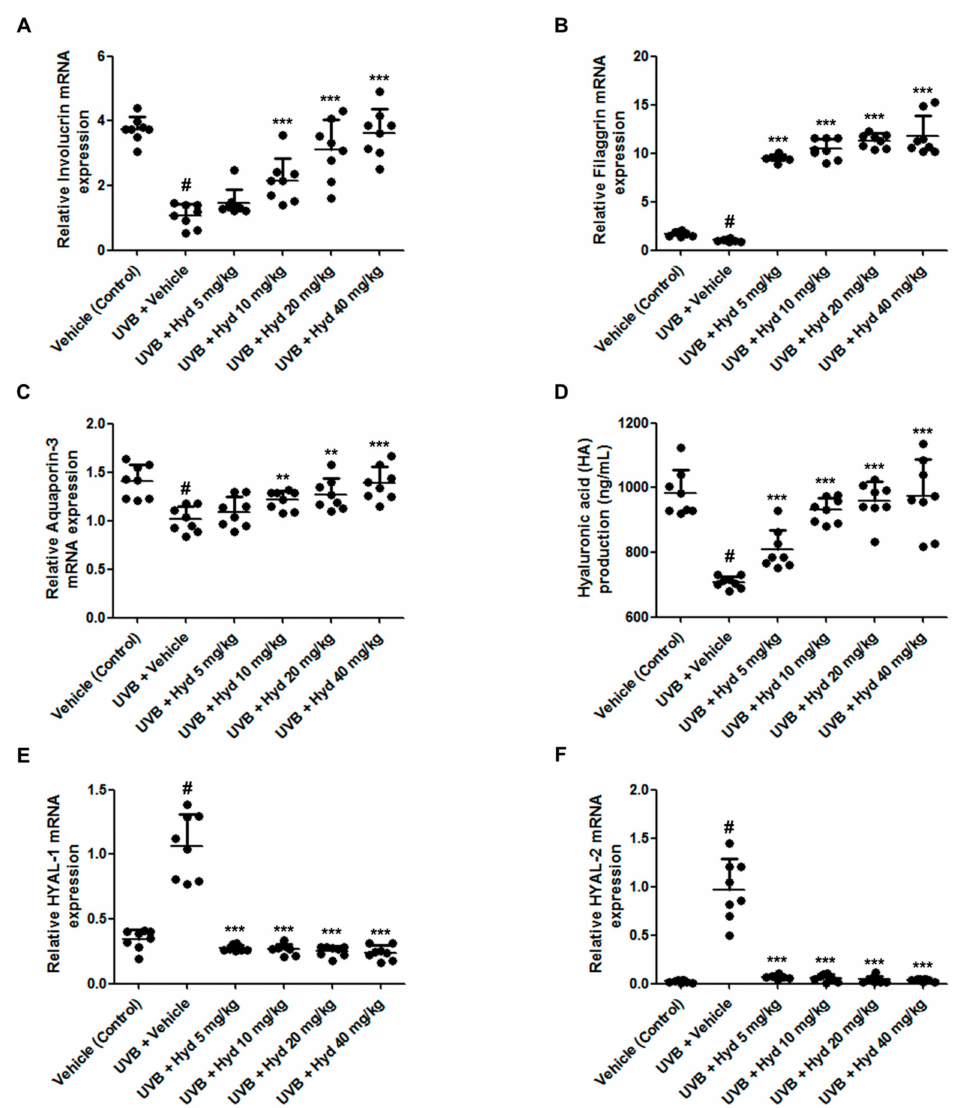
Figure 4. E ff ects of oral administration of hydrangenol on hyaluronic acid content, involucrin, filaggrin, aquaporin-3 (AQP3), and hyaluronidase (HYAL)-1 / -2 mRNA expression in UVB-irradiated hairless mice. HR-1 hairless mice were administered hydrangenol (5, 10, 20, or 40 mg / kg) daily for 7 weeks of exposure to UVB. Total proteins and RNA were extracted from dorsal skin tissues. The mRNA levels of ( A ) involucrin, ( B ) filaggrin, ( C ) AQP3, ( E ) HYAL-1, and ( F ) HYAL-2 were analyzed by qRT-PCR. ( D ) The protein lysates were used to measure hyaluronic acid production. Values are expressed as means ± SD ( n = 8). # p < 0.05 vs. the vehicle-treated control group; ** p < 0.01, and *** p < 0.001 as compared to the UVB + vehicle-treated